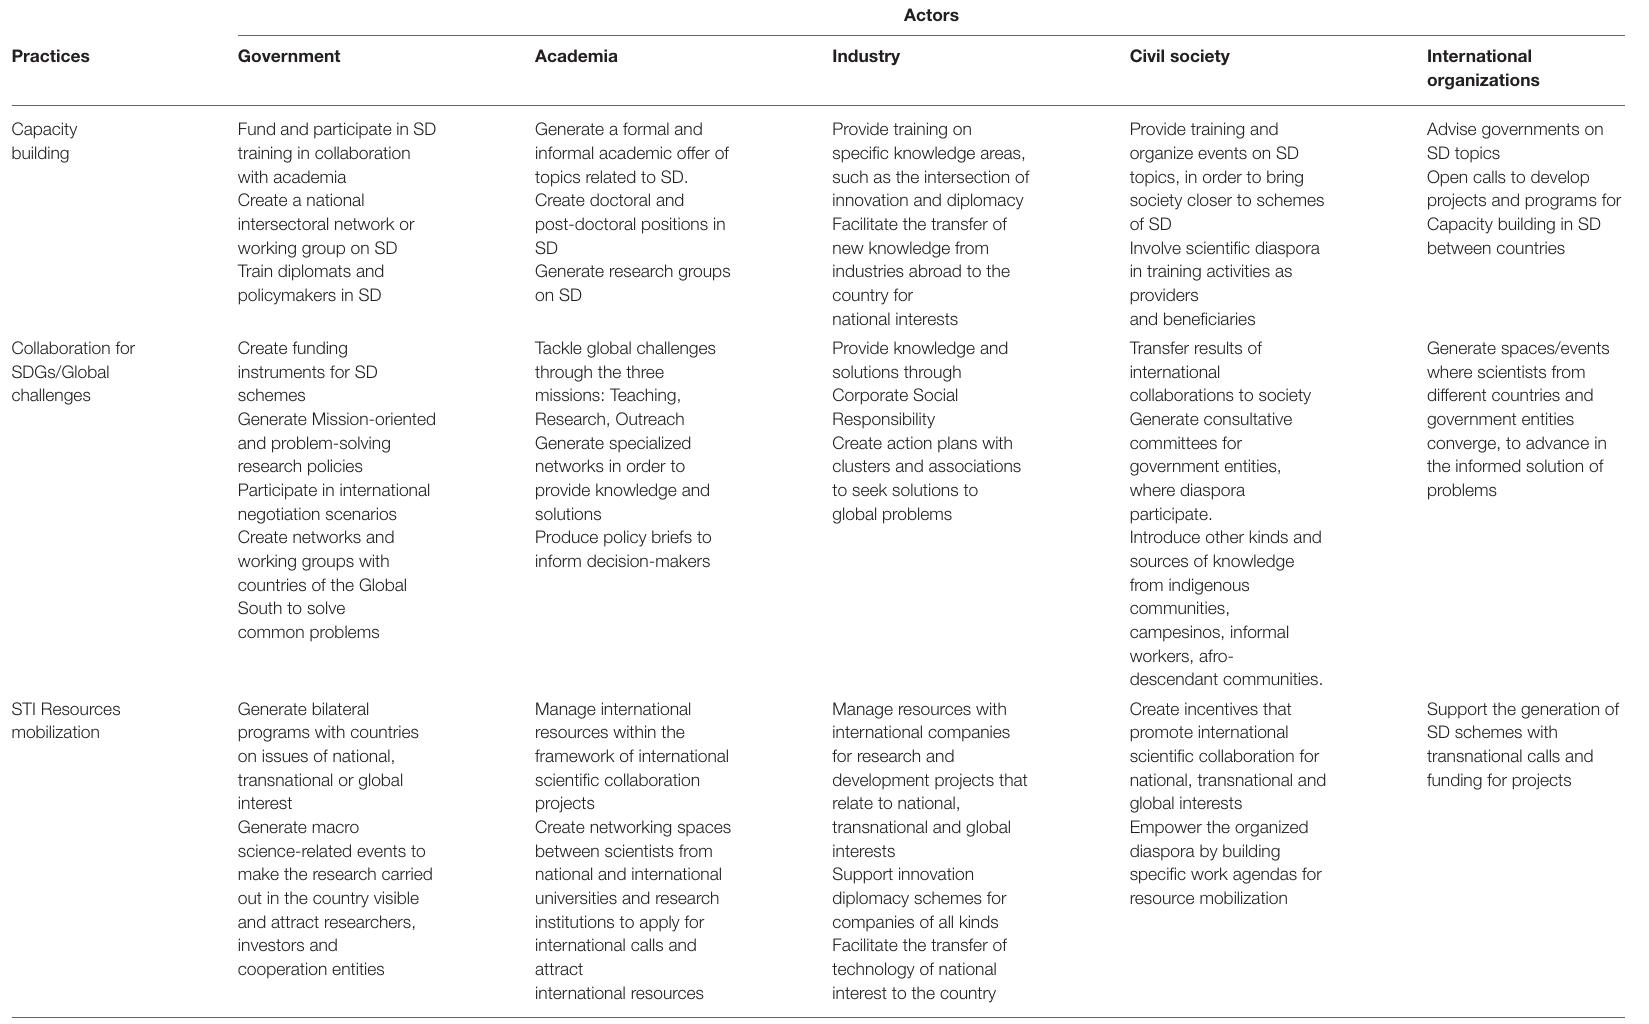
TABLE 3 | Set of recommendations for emerging economies in early stages of progress to advance SD